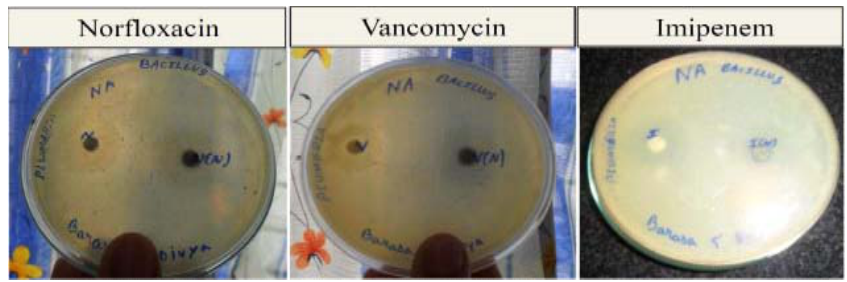
Fig. 3b. Antimicrobial activity of the gold nanoparticles synthesized from Frangipani against Streptobacillus sp.